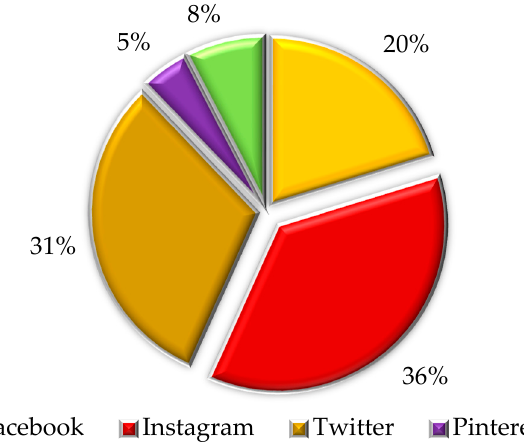
Figure 1. Respondents’ memberships classified by type of social media provider.